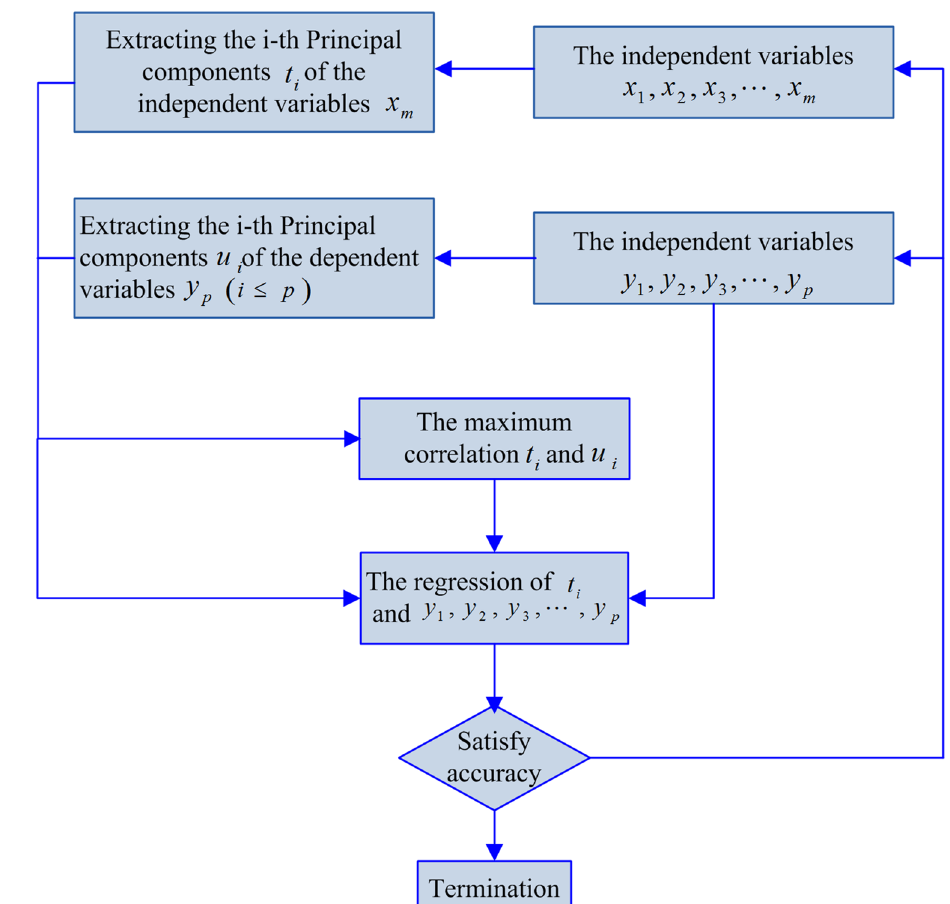
Fig. 10 The process of partial least squares